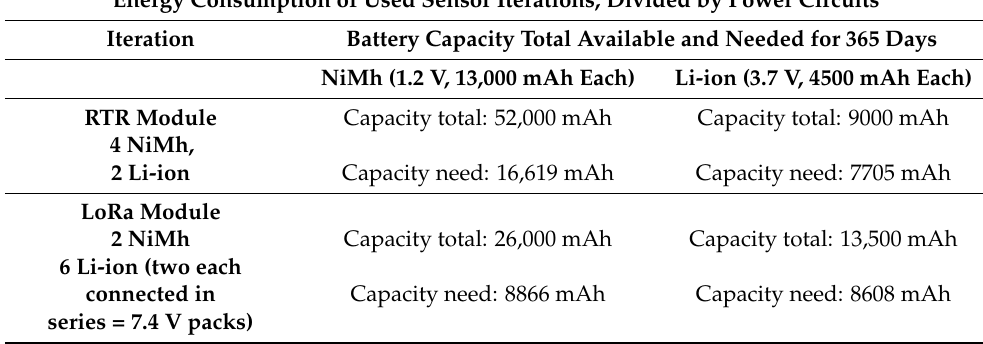
Table 2. Calculated energy usage and available amount of energy for a 365-day period of used node iterations, divided by battery